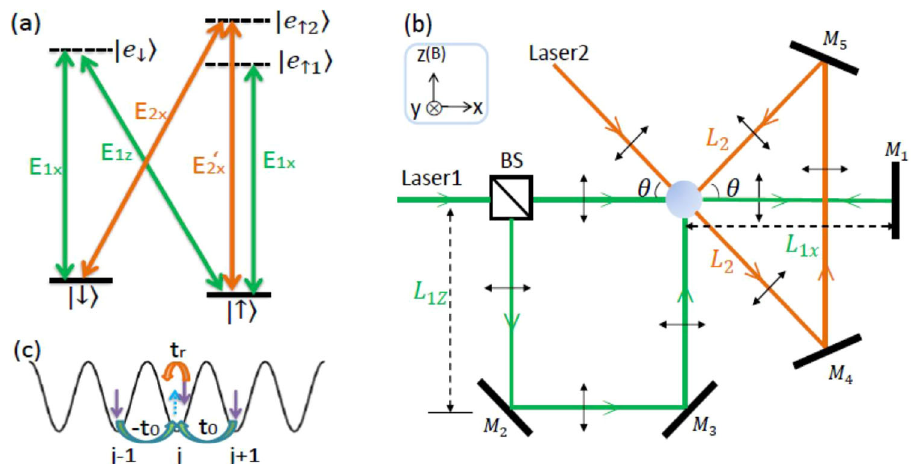
Fig. 1 Schematics of the experimental setup in generating two types of spin-orbit couplings (SOCs). a Two sets of Raman lasers couple the ground spin states via electronically excited states (dashed). b Laser con fi guration and optical-path diagram. The green and orange lines show the propagation directions of the two sets of lasers in a , and the black arrows indicate their polarizations. L 1 x , L 1 z , and L 2 are, respectively, the optical paths from the sample to mirror M 1 , from the beam splitting to mirror M 2 , and from the sample to M 4 (and M 5 ). The optical lattice potential and the Ω 0 -SOC are generated by electric fi elds ( E 1 x , E 1 z ), and the Ω r -SOC is created by electric fi elds ( E 2 x ; E 0 ). c The Ω 0 - and Ω r -SOCs, respectively, generate the nearest-neighbor and the 2 x e i ϕ 0 ð(cid:2) 1 Þ j and Ω e i ϕ r j ( j is the site on-site spin fl ip with tunable strengths Ω r 0